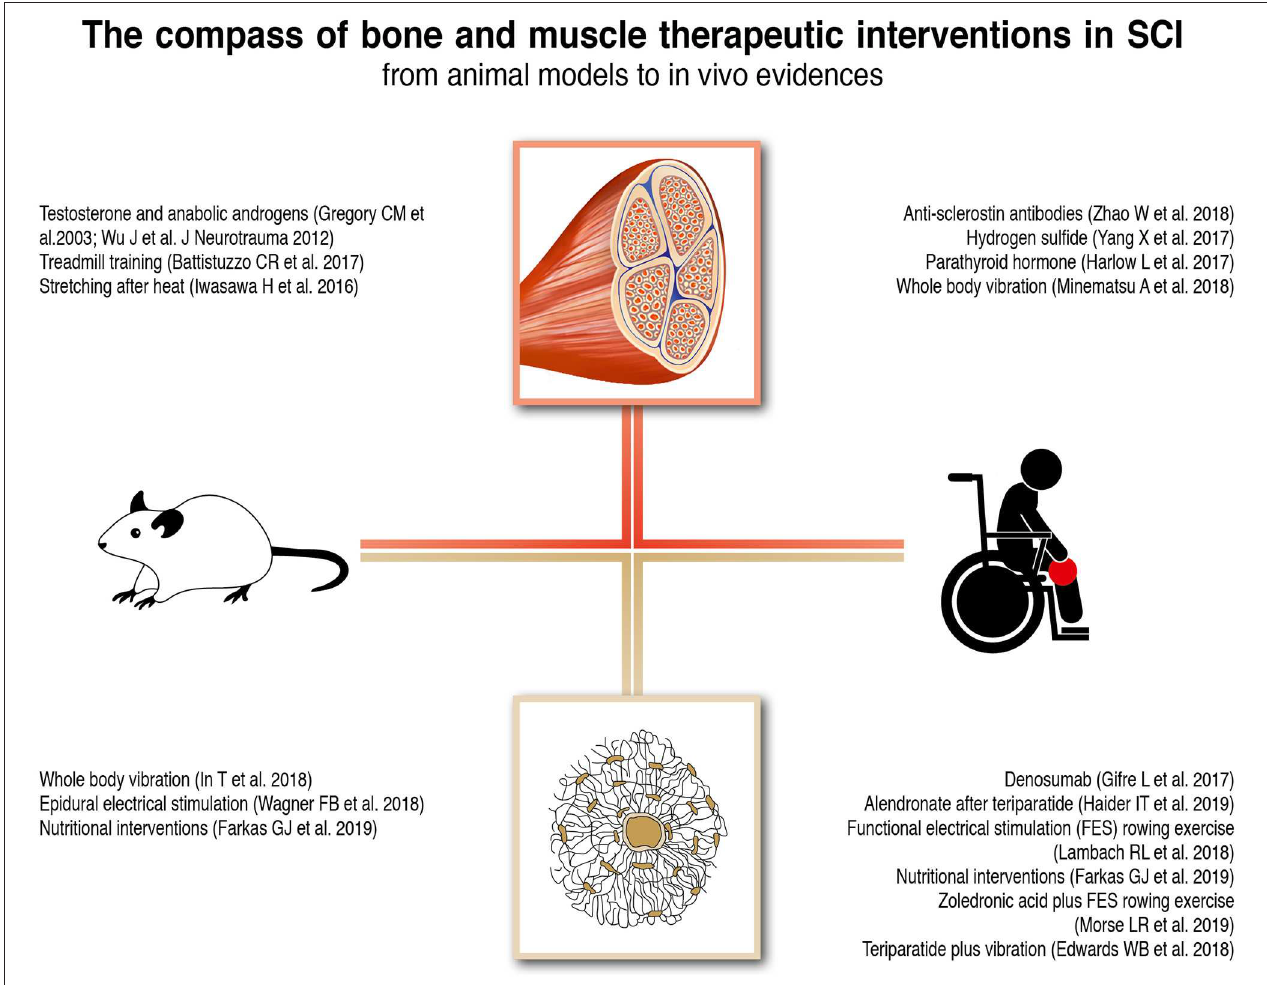
FIGURE 2 | Bone and Muscle therapeutic interventions in SCI animal models and human subjects.